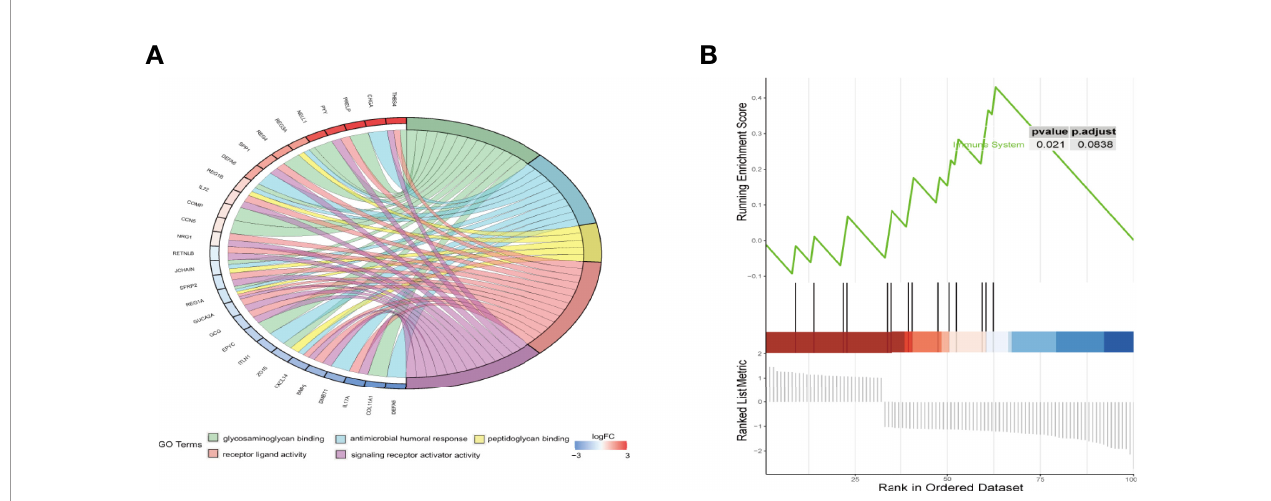
FIGURE 6 | Functional enrichment analysis of DEGs between the high- and low-risk groups. (A) The chord plot of GO enrichment analysis. (B) Gene set enrichment analysis (GSEA) of hallmark gene sets regarding DEGs between high- and low-risk